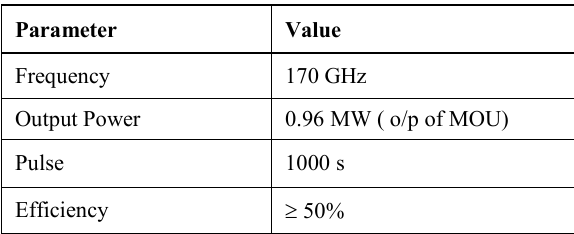
Table 1 : Typical specifications of Test